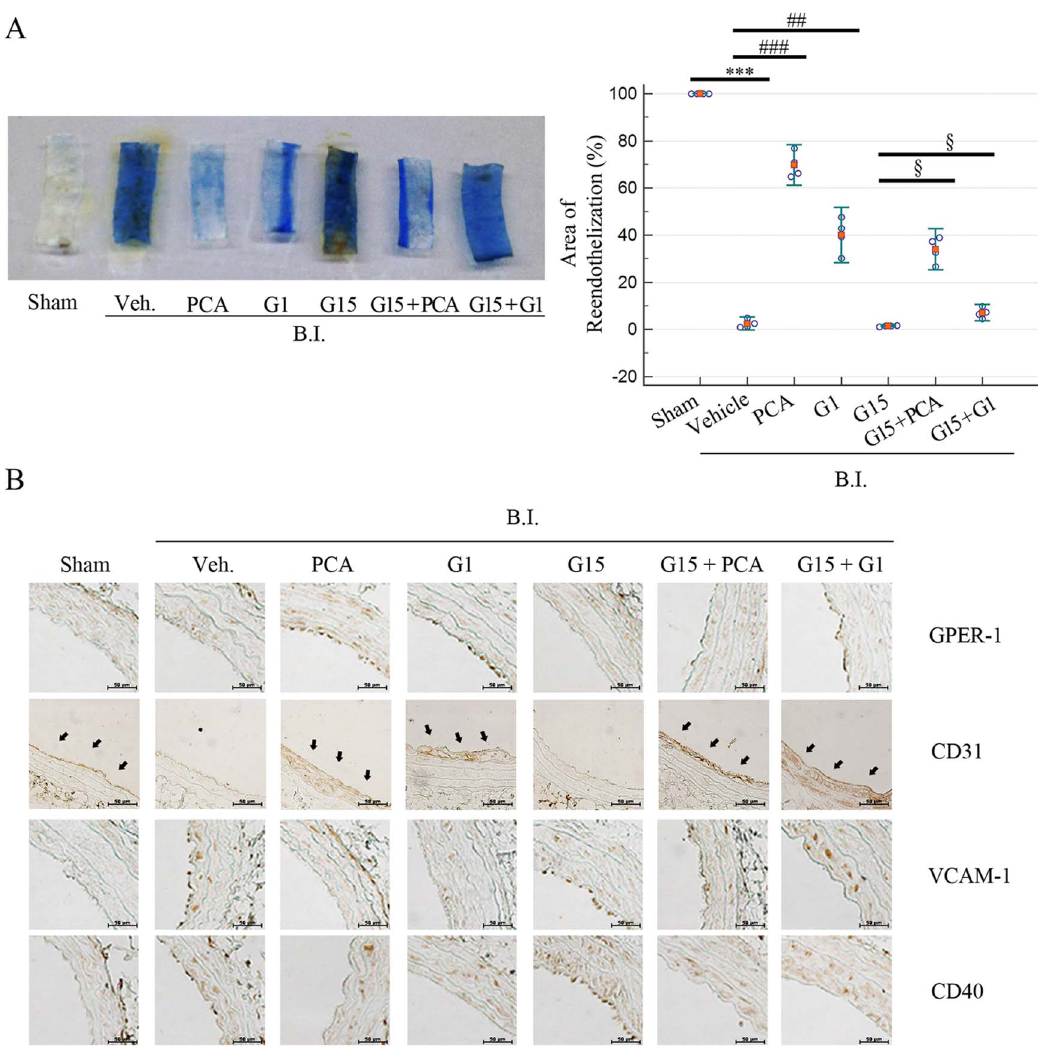
Figure 4. Protocatechuic aldehyde exhibits endothelial protection. ( A ) Re-endothelization of a Sprague Dawley rat carotid artery determined by Evans Blue staining (de-endothelized areas are stained with blue). Ratios of surface covered by endothelium to the total area in sham, vehicle, and injured (Inj) groups treated with different substances as follows: PCA, G1, G15, G15 + PCA, G15 + G1 (n=4 each). ( B ) Cross sections of rat common carotid arteries stained with CD31 antibody 3 days after injury. Also, targets related to inflammatory markers were observed including VCAM-1, CD40 and GPER-1. Data are presented as mean 6 SEM; *** indicates P , 0.001 compared to the sham group. ## and ### indicate P , 0.005 and P , 0.001, respectively, compared to the vehicle group. 1 indicates P , 0.05 compared to the G15 + Inj. group.